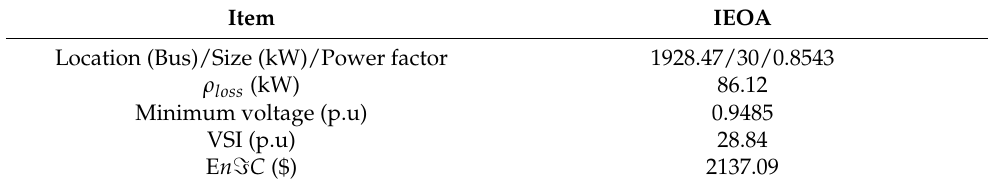
Table 5. The results of multi-criteria wind turbine allocation in a 33-bus network based on SMM. Item IEOA Location (Bus)/Size (kW)/Power factor 1928.47/30/0.8543 ρ loss (kW) 86.12 Minimum voltage (p.u) 0.9485 VSI (p.u) 28.84 E n (cid:61) C ($)